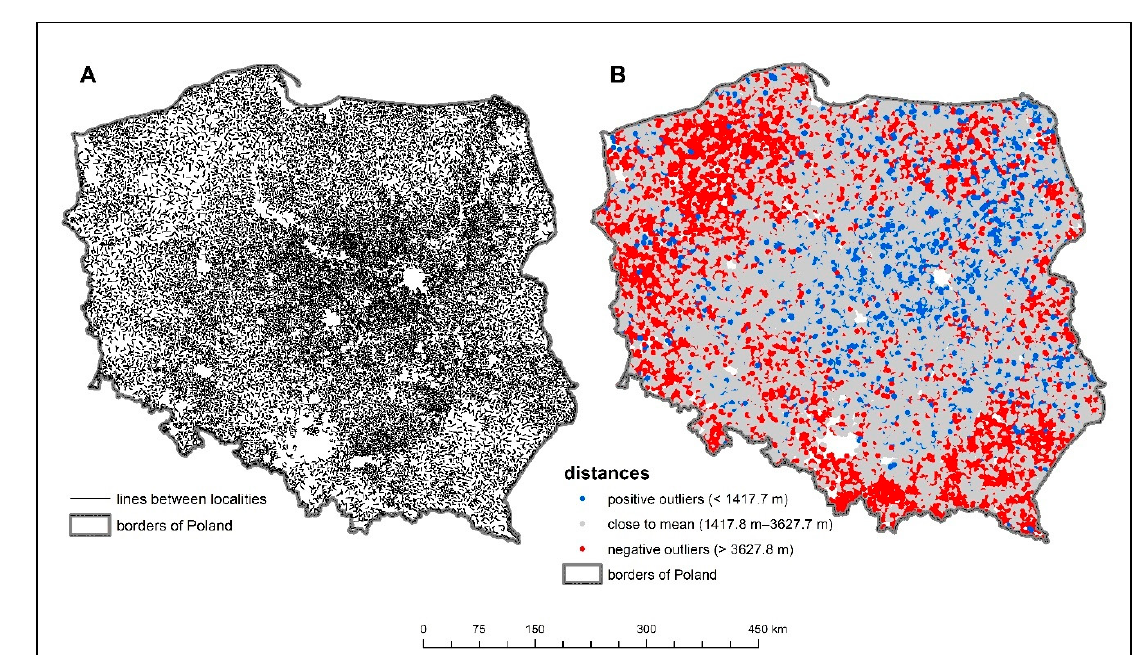
Figure 3. Density of the settlement network of rural statistical localities: ( A ) Connections between nearest rural statistical localities, ( B ) Localities by distance to nearest neighboring rural statistical localities.